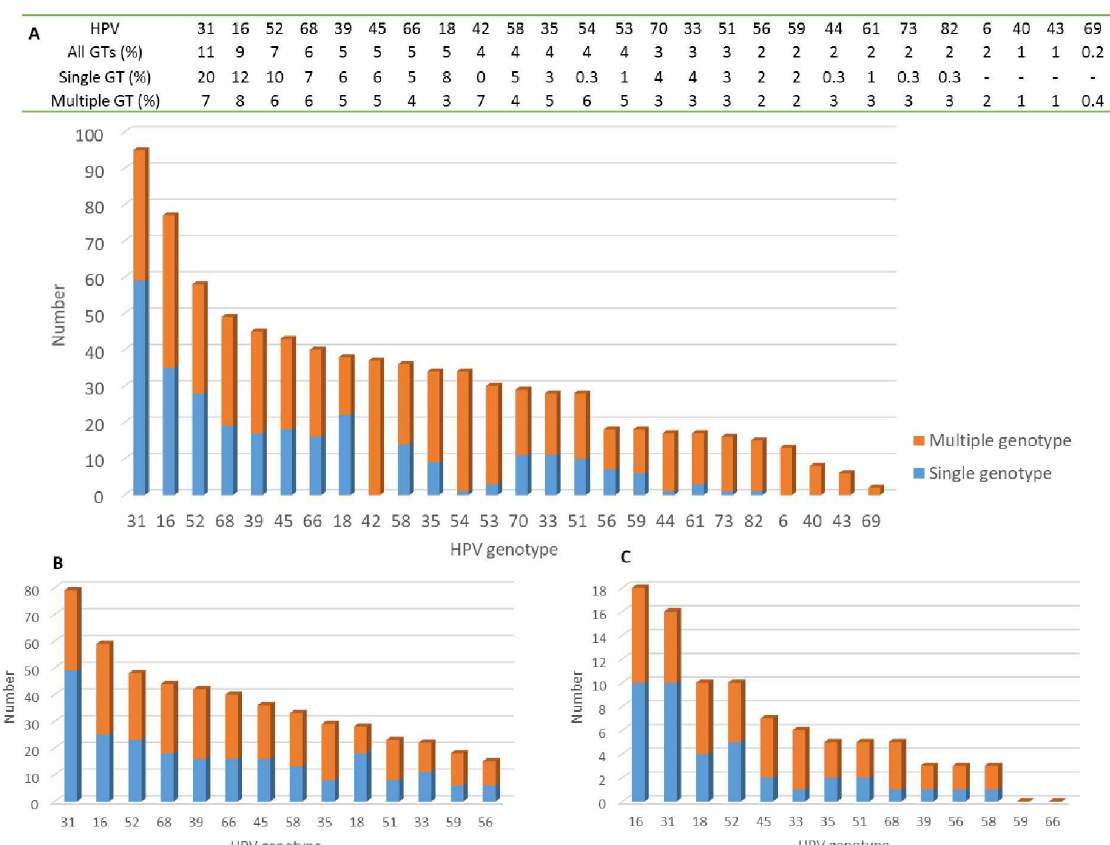
Fig 2. Total genotype distribution. Presentation of results from DNA genotyping from detected high-risk and low-risk HPV in both single- and multiple-genotype–positive samples in the screening population of women 30 years and older in O¨rebro, Sweden. A. All samples combined with numbers presented in the bar chart and proportions in table above. B. Samples among controls (normal cytology, � LSIL cytology, LSIL histology, and normal histology), including genotypes included in Aptima. C. Samples among cases ( � HSIL histology), including genotypes included in Aptima. HPV genotype is presented on the x-axis and number of positives for respective genotype on the y- axis. Blue bars constitute genotypes detected in samples with only one genotype (GT), and red bars represent GTs detected in samples containing more than one GT (multiple